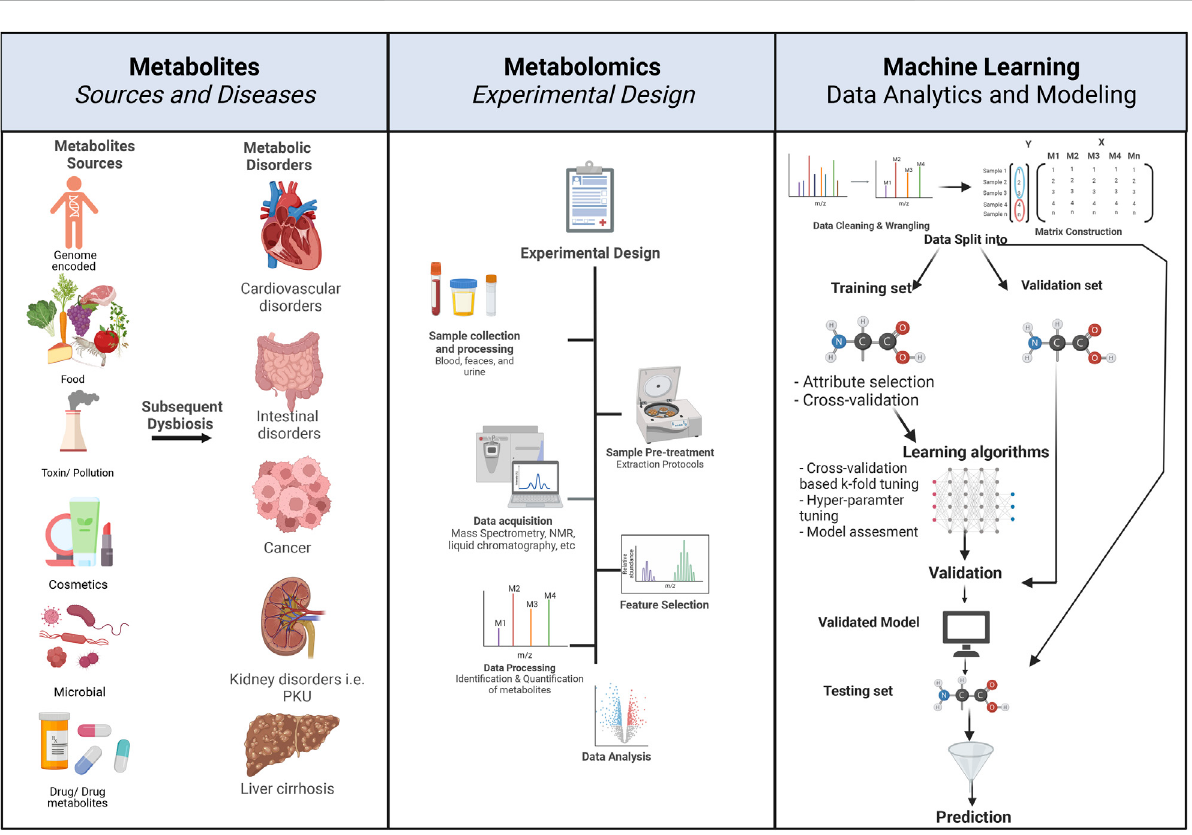
FIGURE 1 Principles of metabolomics experimental design and associated ML work fl ow. The left panel describes the various sources of metabolites. Metabolite exposure can be through endogenous and exogenous means, e.g., human-encoded, microbiome-encoded, food, drugs, and toxins. Metabolic dysbiosis can be associated with metabolic disorders, e.g., cancer, cardiovascular disease, intestinal disorders, and diabetes. The center paneldescribesthetypical fl owanddesignofametabolomicexperiment,startingwiththe1)studydesignwherediseaseandcontrolgroupsare determined, 2) followed by sample selection, e.g., urine, stool, blood, and serum, 3) collected samples undergo pre-treatment and processing according to experimental design, 4) data acquisition, e.g., through mass spectrometry or NMR, 5) feature selection involves the identi fi cation of desired metabolite features that will undergo subsequent, 6) data processing through the quanti fi cation of metabolites, and fi nally, 7) data analysis depends on the study design. The right panel describes the concepts of ML work fl ow and prediction, starting with 1) data wrangling and cleaning, 2) matrix construction, where data from each metabolite is placed in a matrix in reference to the conditions, i.e., disease (marked in red), control (markedinblue),3)dataarethendividedintotesting,validationandtrainingdatasets,4)MLalgorithmisapplied,and5)cross-validation,andtestingof the predictive power of the algorithm on a test dataset. Created with